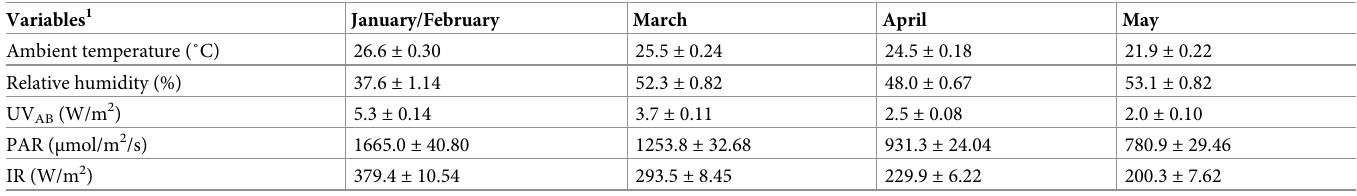
Table 7. Mean daily ( ± SEM) outdoor conditions during ranging time across the months in WA (n = 67 days). Variables